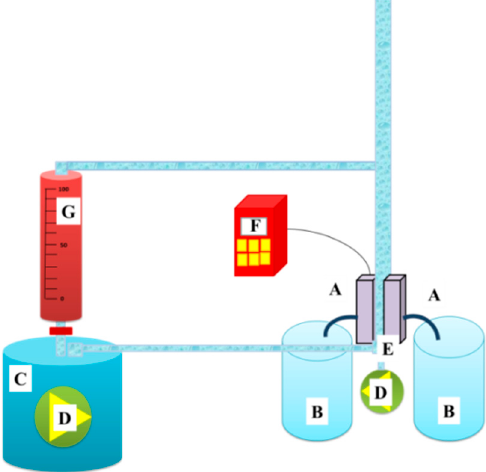
Figure 4. A cross-flow unit: ( A ) membrane cells, ( B ) permeate, ( C ) feed, ( D ) pump, ( E ) surface bubble cleaning, ( F ) pressure controller, and ( G ) feed flow speed controller.